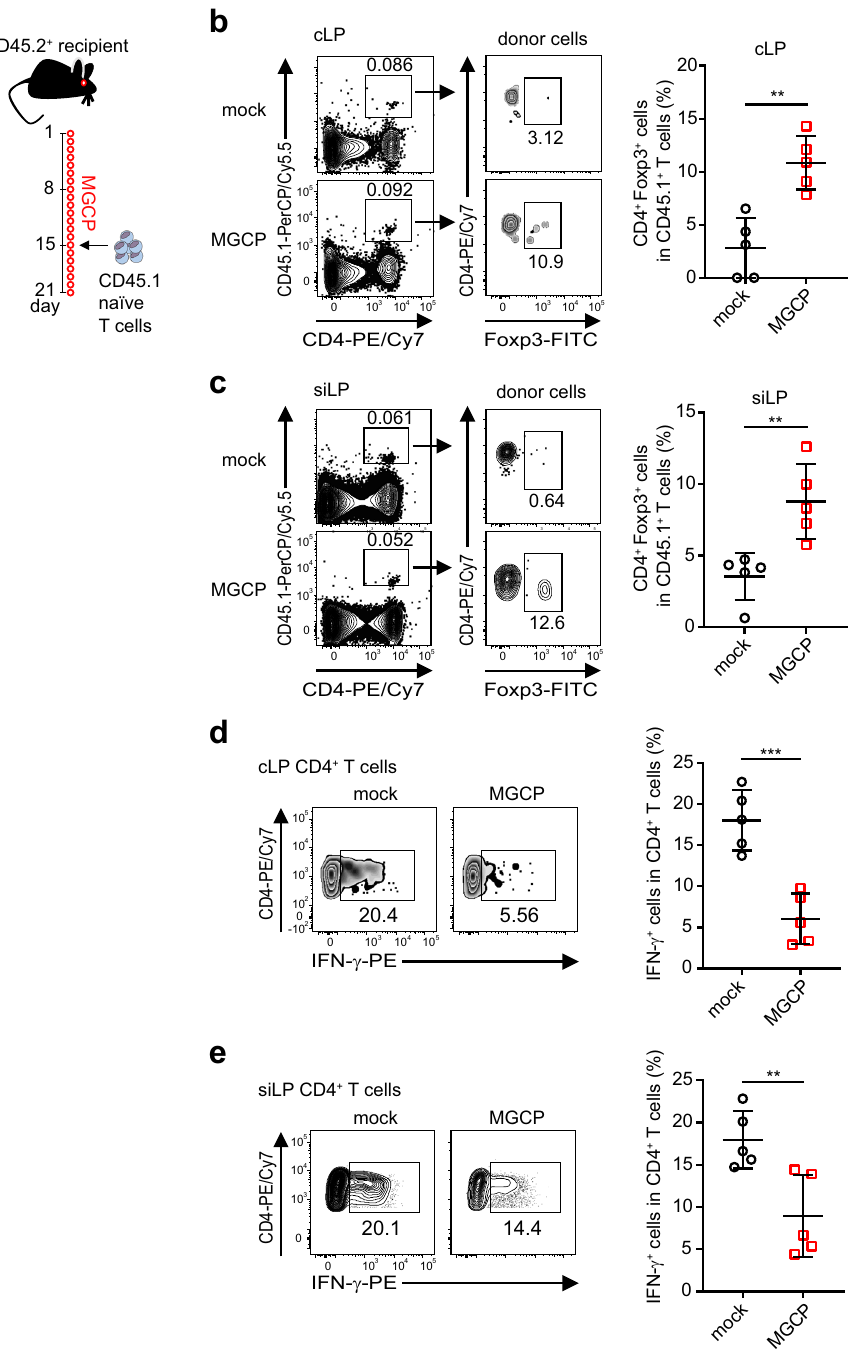
Fig. 4 MGCP administration in vivo promotes de novo iTreg generation and suppresses IFN- γ production. a Experimental scheme. Mice were administered either mock (DW) or MGCP every day for 2 weeks prior to receiving congenically marked naive CD4 + T cells (CD45.1 + CD4 + Foxp3 − CD44 lo CD62L hi ). MGCP was administered for 1 additional week after cell transfer, after which intestinal CD4 + T cells were analyzed. b , c Representative fl ow cytometric plots (left panel) and frequencies (right panel) of de novo generated Treg cells originated from donor cells (CD45.1 + CD4 + ) in lamina propria of colon ( b ) and small intestine ( c ). d , e Representative fl ow cytometric plot (left panel) and frequency (right panel) of IFN- γ + effector CD4 + T cells (CD4 + Foxp3 − ) in colon ( d ) and small intestine ( e ). Each dot represents individual mouse. All data are analyzed with pooled data from 2 independent experiments with 5 mice. All graphs show the mean±SD. ** p < 0.01, *** p <0.001 (two-tailed student ’ s t test). Source data are provided as a Source data fi